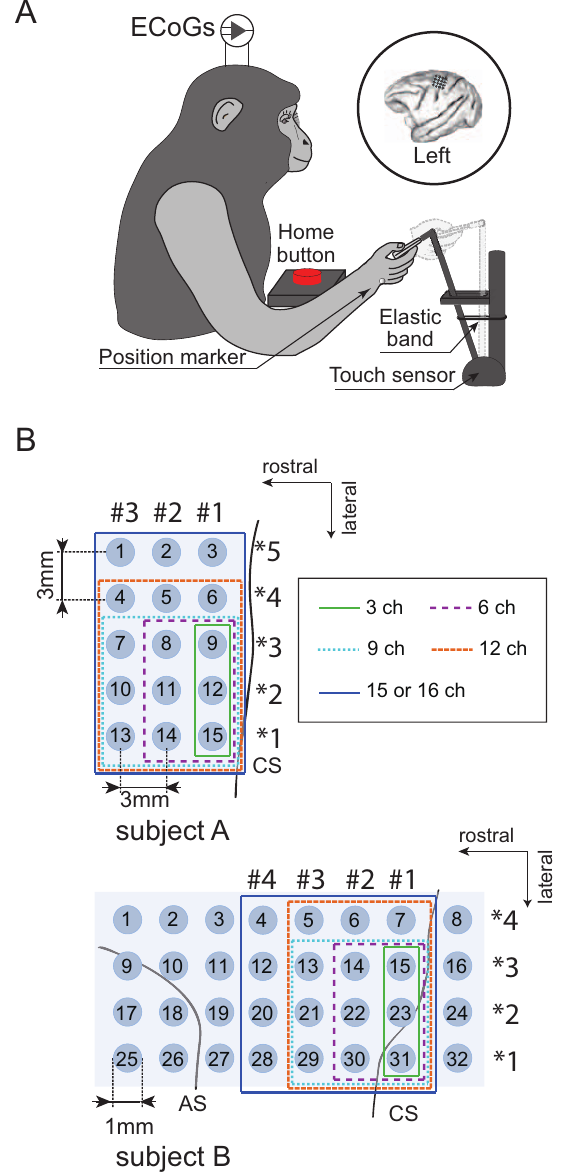
Figure 1. Behavioral task and location of ECoG electrodes used in decoding. A) Monkeys performed right hand reaching, grasping, pulling, and releasing tasks in a 3D workspace. During the task, ECoG and hand positioning were recorded simultaneously. B) The planar- surface platinum electrode arrays were implanted on the gyrus between the central sulcus (CS) and the arcuate sulcus (AS) in the primary motor area in left hemisphere. The locations of all 15 and 32 electrodes in monkey A and monkey B are shown with defined channel numbers. Locations of 3, 6, 9, 12, and 15 or 16 electrode groups used in decoding are denoted with green solid, purple dotted, blue dotted, brown dotted, and blue solid lines, respectively. The column nearest the CS was column # 1 in the rostral-caudal direction, and the row in the medial-lateral direction was row *1. Note that electrodes inside the blue line were used in both column and row decoding.